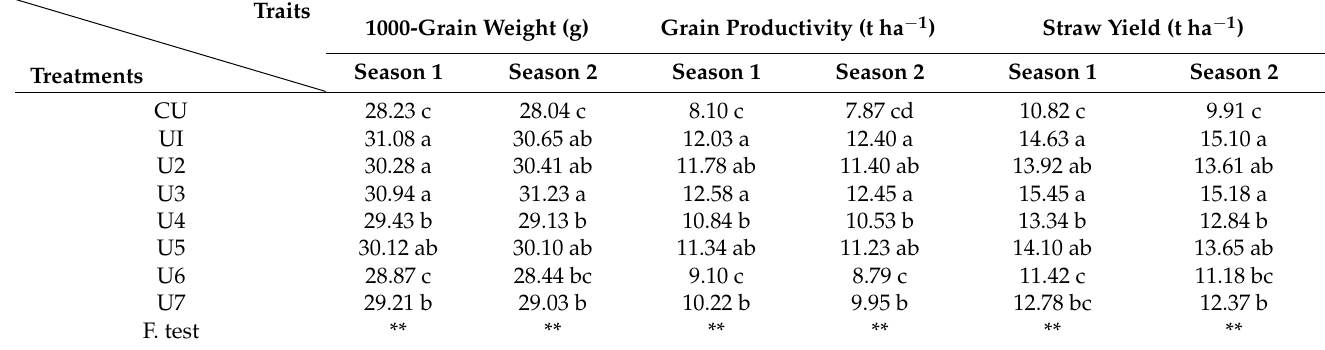
Table 7. Effects of different rates of classical urea fertilizer, urea chitosan nanohybrid and their combinations as exogenous application on 1000-grain weight, grain productivity, and straw yield of rice plants during the 2020 and 2021 seasons.